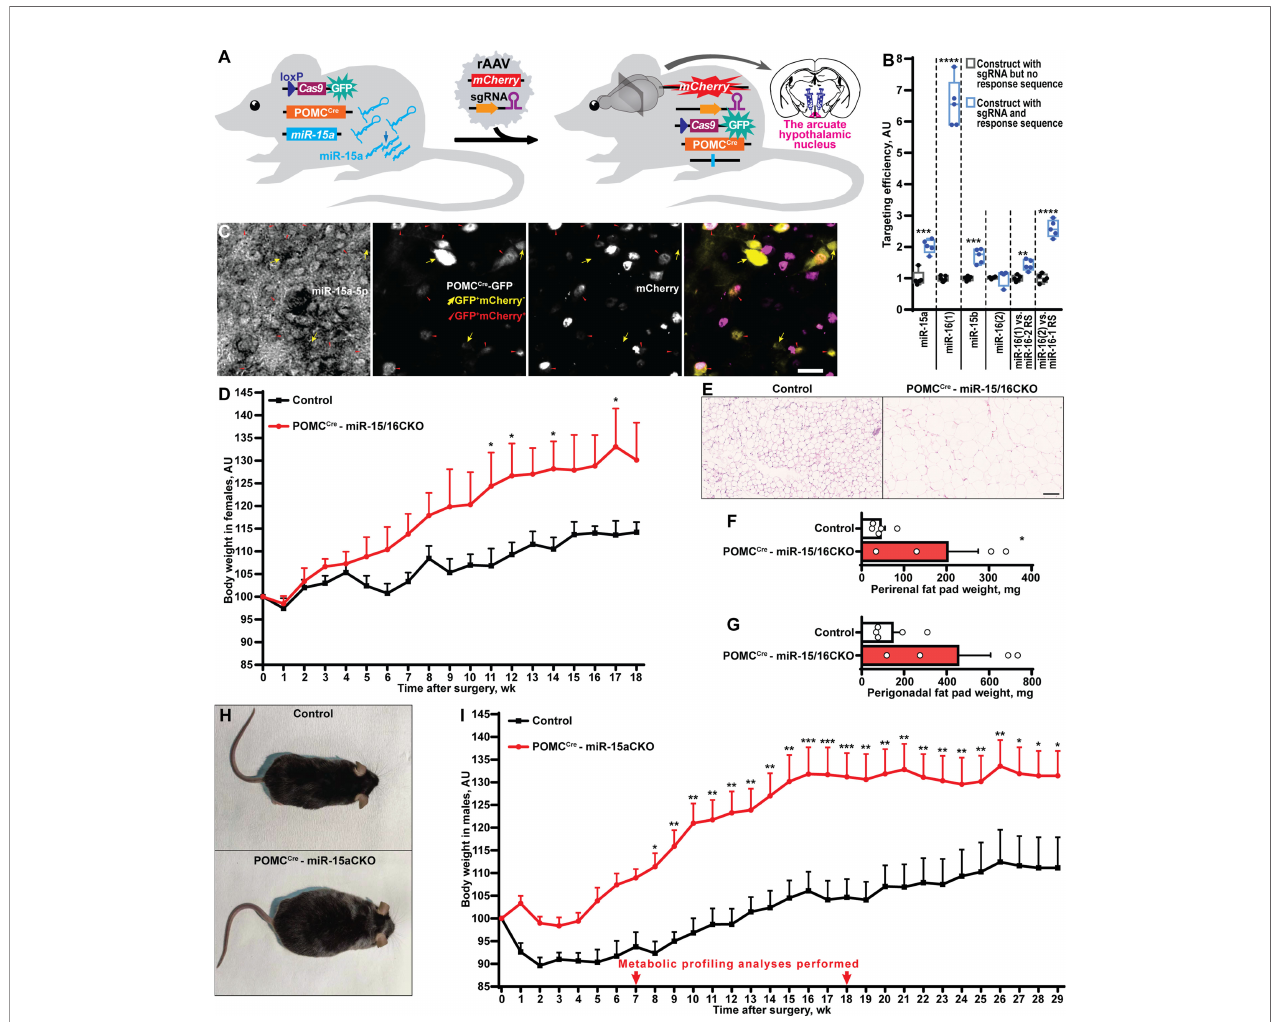
FIGURE 3 | POMC Cre -restricted depletion of miR-15a causes obesity in mice. (A) Scheme of the experiment to inactivate the miR-15a/16-1 cluster or all miR-15 family microRNAs by injection of single guide RNA-equipped recombinant adeno-associated virus (rAAV) to the arcuate hypothalamic nucleus of POMC Cre Cas9 males or females, respectively. (B) On-target effectivity validation of single guide RNAs to targeting the miR-15 family (n = 5, 5, 5, 4, 5, 5, respectively for the indicated comparison groups). (C) Microphotographs of the arcuate hypothalamic nucleus stained by in situ hybridization probe against miR-15a-5p, anti-EGFP antibody labelling POMC Cre -GFP neurons and anti-mCherry antibody staining sgRNA-equipped rAAV-transduced cells. POMC Cre -GFP neurons effectively transduced (POMC Cre GFP + mCherry + ) or not transduced (POMC Cre GFP + mCherry - ) by rAAVs are indicated by red triangles or yellow arrows, respectively. (D-G) Body weight dynamics (D) , hematoxylin and eosin staining (E) and weight of perirenal fat tissue (F) , perigonadal fat pad weight (G) in POMC Cre – miR-15/16CKO and control female mice (n = 4 and 5, respectively). (H, I) Representative photographs (H) and weight gain dynamics (I) in POMC Cre – miR-15aCKO male mice and controls (n = 8 and 10, respectively). Error bars represent SEM. * p < 0.05; ** p < 0.01; *** p < 0.001; **** p < 0.0001 as assessed by unpaired two-tailed Student ’ s t-test (B, F, G) or 2-way ANOVA ( D , F (18, 126) = 26.28, F (7, 126) = 47.22 and F (18, 126) = 4.31 for time, experimental group and interaction factors; I , F (29, 413) = 10.77, F (1, 413) = 309.67 and F (29, 413) = 1.32 for time, experimental group and interaction factors) followed by Holm-S ̌ ı ́ da ́ k pairwise comparison